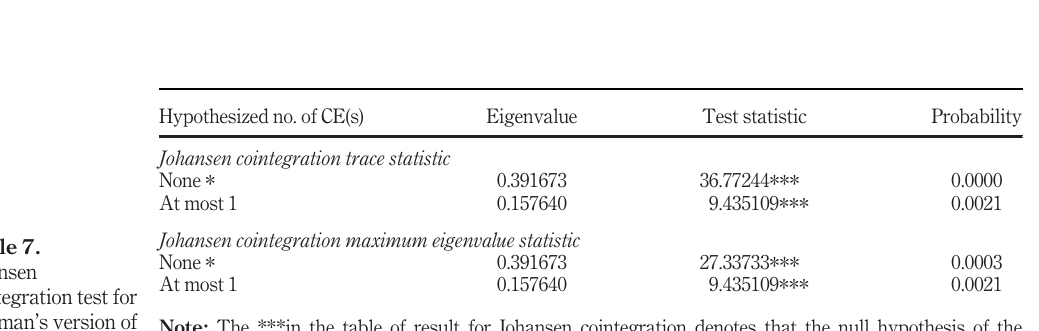
Table 6. Johansen cointegration test for Gupta ’ s version of Wagner ’ s law